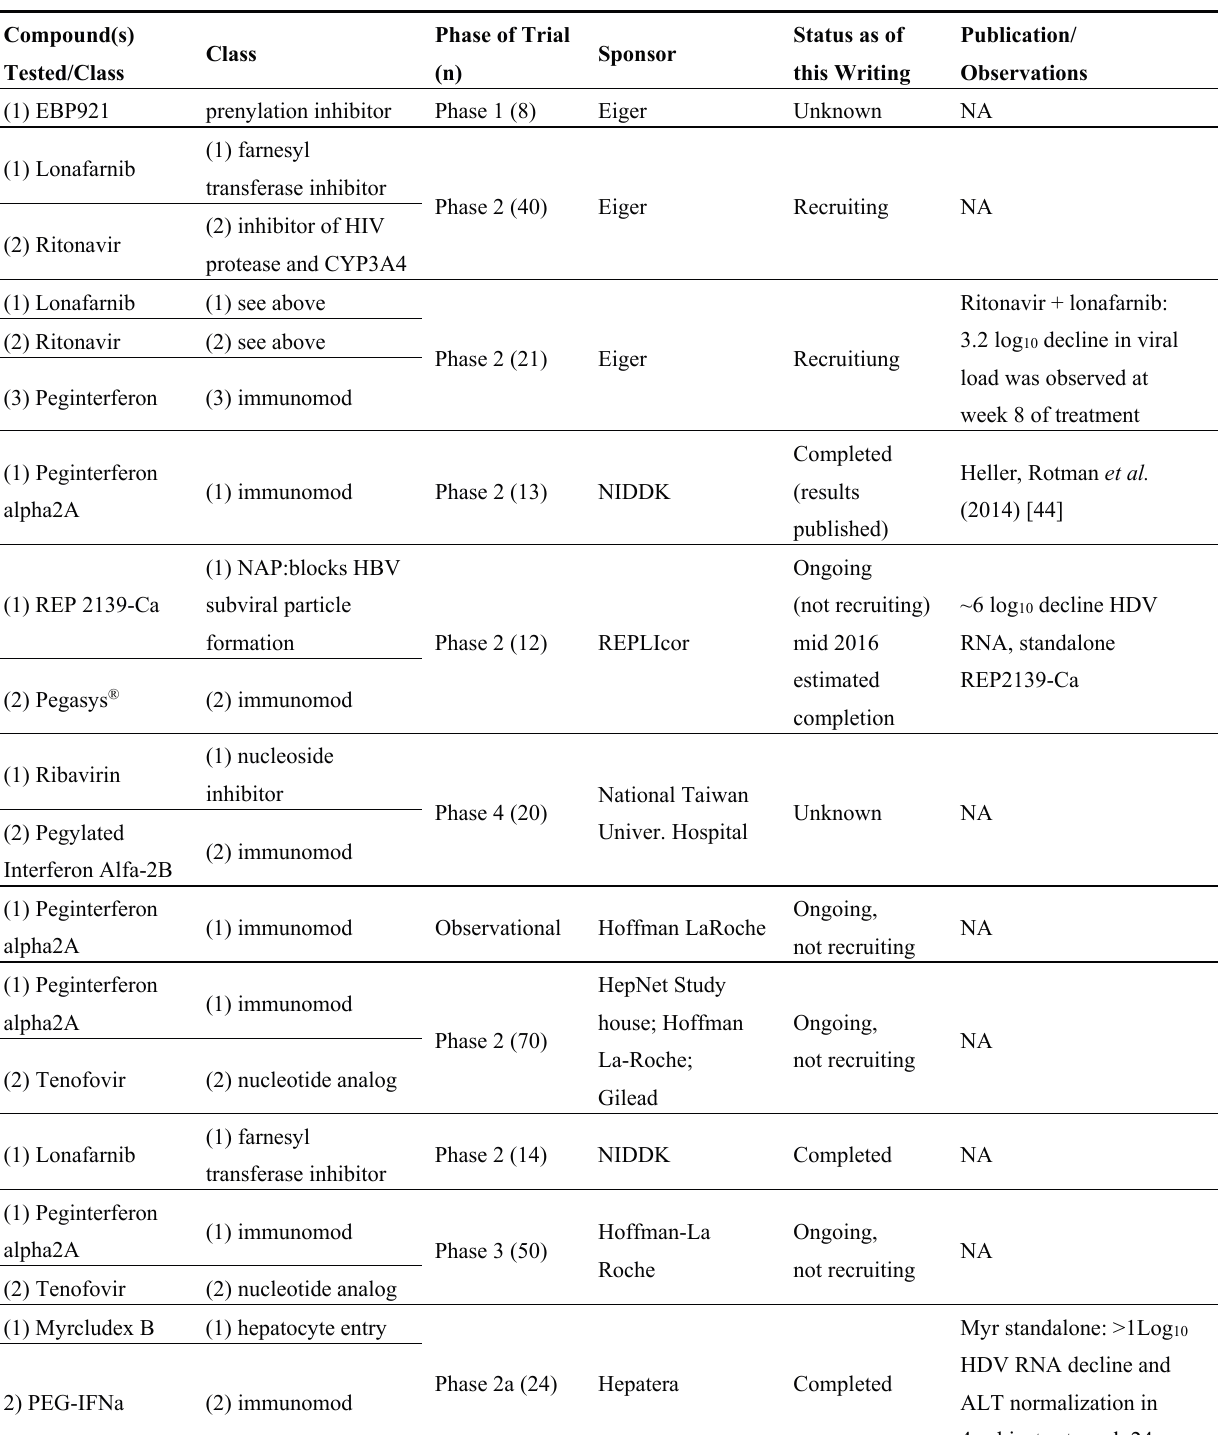
Table 1. Current or recently completed clinical trials testing therapies for chronic hepatitis delta (CHD) infection. Abbreviations: Immunomod: immunomodulatory mechanism; NAP: Nucleic Acid Polymer; CYP3A4, Cytochrome P450 3A4; NA, not applicable. Eiger: Eiger